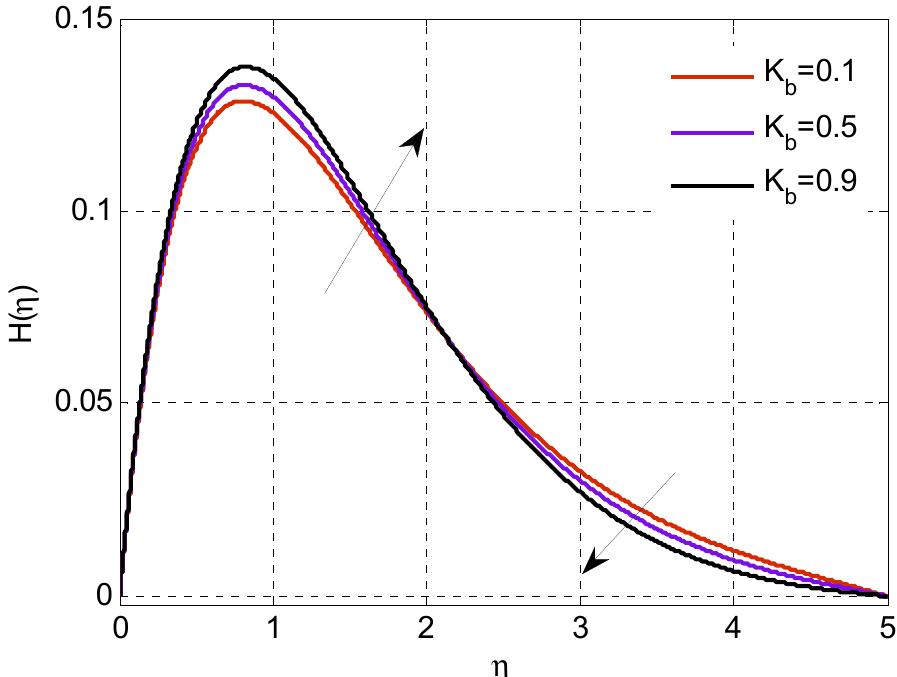
Figure 8. Effect of coupling parameter on angular velocity using G = 1, λ = 0.1, F r = 0.1, and N = 3040 .